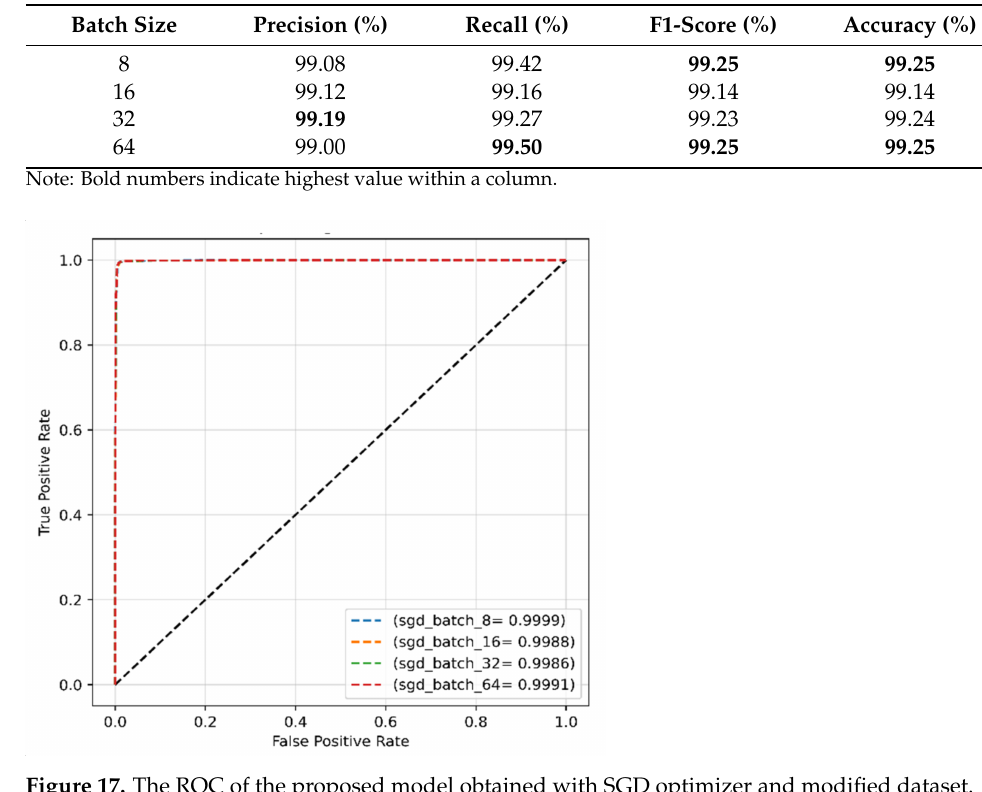
Figure 16. Confusion matrix of the proposed model obtained with modified dataset, SGD optimizer, and batch sizes of ( a ) 8, ( b ) 16, ( c ) 32, and ( d ) 64. Table 5. Model’s performance for various batch sizes with SGD optimizer and modified dataset.